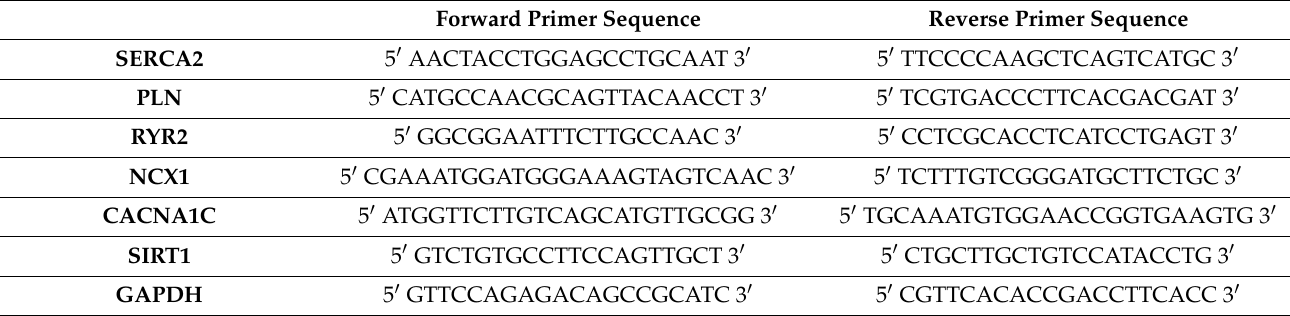
Table 1. Specific primers used for qPCR